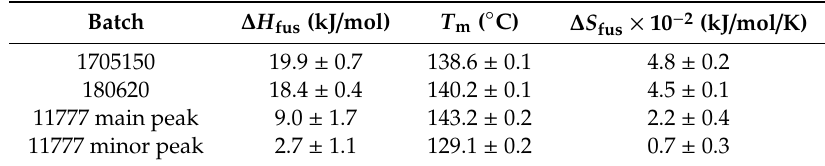
Table 4. Thermal properties of venetoclax. Enthalpy of fusion ( ∆ H fus ), melting point ( T m ) and entropy of fusion ( ∆ S fus ).